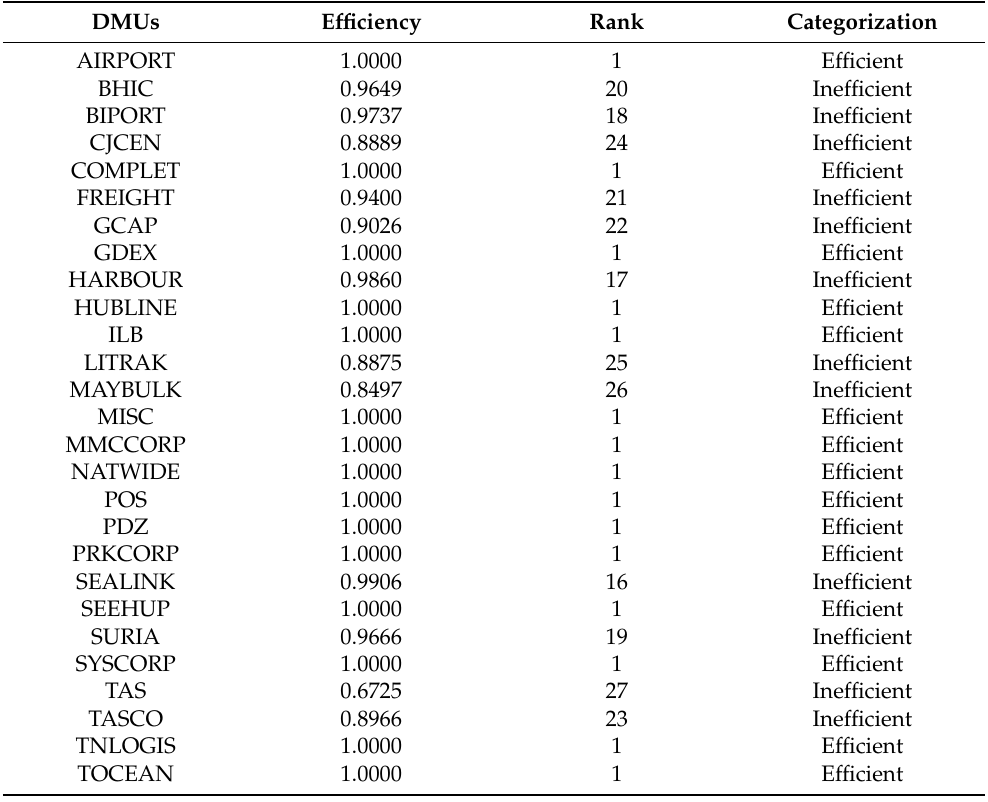
Table 2. Efficiencies of the listed logistics companies.